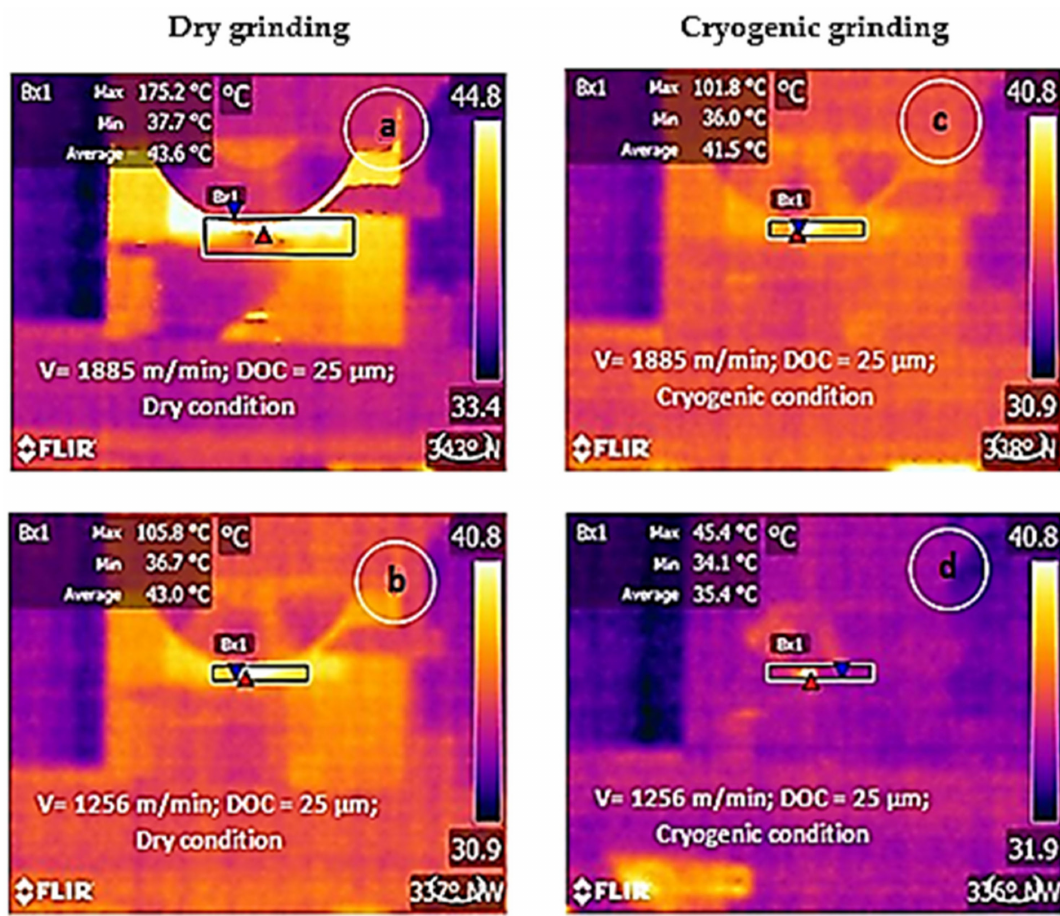
Figure 4. Thermal camera images captured under various grinding conditions ( a , b ) dry grinding; ( c , d ) cryogenic